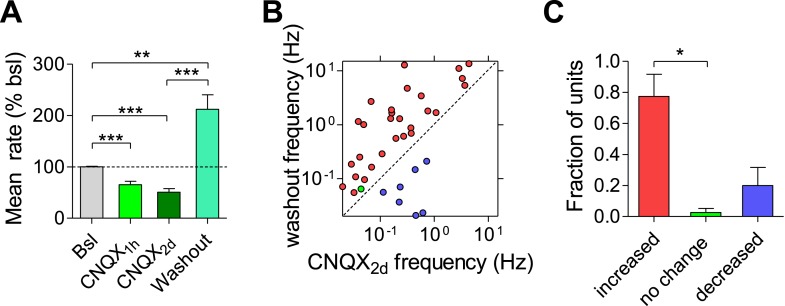
CNQX washout reveals an increase in the mean firing rate.(A) Washout of CNQX causes an increase in MFR relative to both baseline and after 2 days CNQX incubation (relative to baseline: 212% ± 28, relative to 2 days CNQX: 442% ± 67; n = 51 units). (B) Per unit correlation between firing rates before and after washout of CNQX. Colors represent units that significantly increased (red), decreased (blue), or remained stable (green) as determined by bootstrapping. Note log scale of both axes. Same units as in (A). (C) Summary of data in (C).